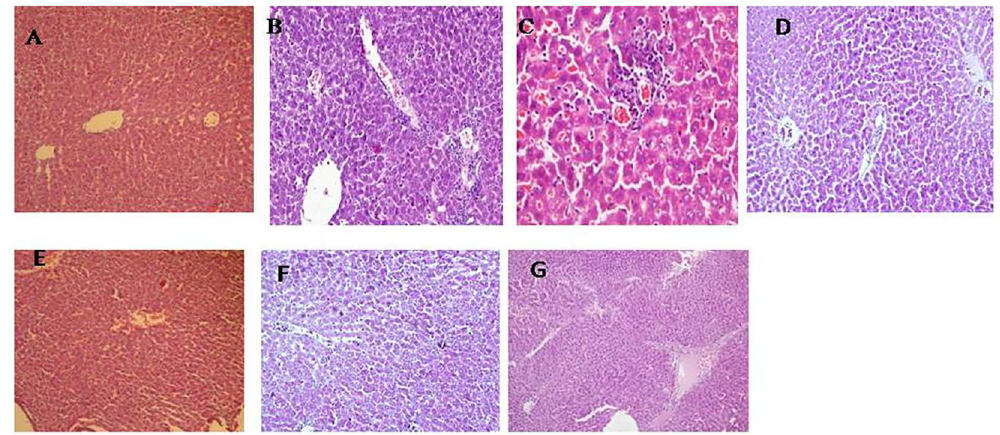
Fig 4. Representative photomicrographs of hematoxylin-eosin stained rat liver sections. (A) Normal rat liver (100x); B,C) Liver section from rat administered 10-14g/kg body weight of 35% alcoholorally for 12 weeks showing vacuolardegeneration, microvesicular fatty change,focal collectionof lymphocytesand vascular congestion(200X, 400X respectively); D) Photomicrographof alcoholadministered co-supplemented with free probiotic-EGCG group showingnormal histology(100X); E) Photomicrographof alcoholadministered co-supplemented with encapsulated probiotic—EGCG group showing normal histology(100X); F) Photomicrograph of Free probiotic-EGCG per se group showingnormal histology(100X); G) Encapsulated probiotic+EGCG per se group showingnormal histology (100X).